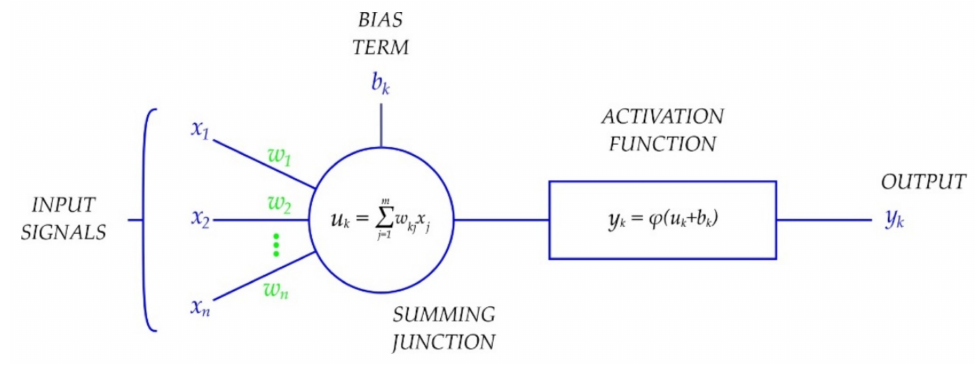
Figure 4. Nonlinear model of a neuron (according to: